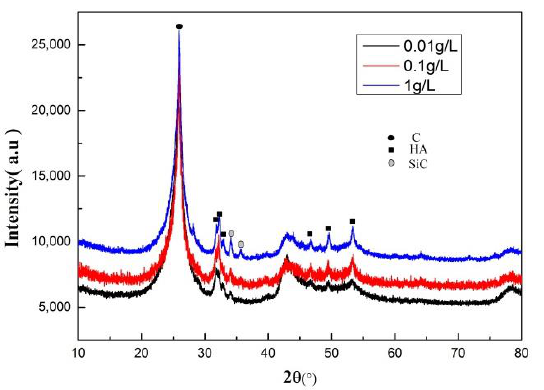
Figure 6. X-ray diffraction of SiC-hydroxyapatite coatings at different SiC particle (200 nm) con- centrations.